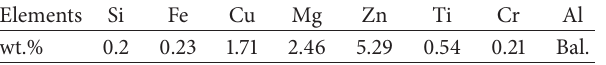
Table 1: Chemical composition of AA 7075 alloy. Elements